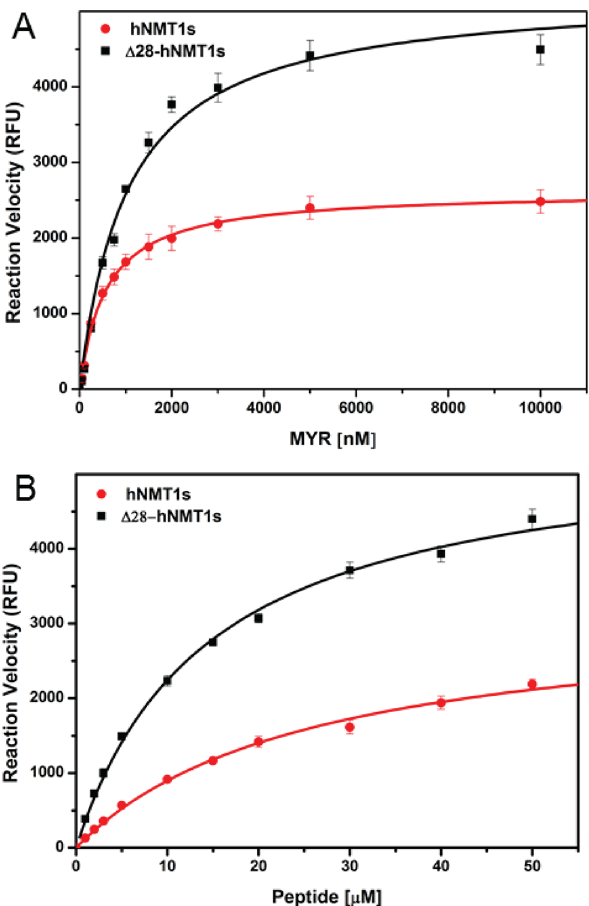
Fig 6. Analyses of catalytic efficiencies of hNMT1s and Δ 28-hNMT1s. Enzymatic activity of 5 nM of hNMT1s and Δ 28-hNMT1s was assayed in 200 μ l of 20 mM sodium phosphate buffer (pH 7.5) with 0.5 mM EDTA, 0.5 mM EGTA, and 0.1% (v/v) Triton X-100 at 25°C using the fluorescence assay as described under “ materials and methods ” . Plots of reaction velocity versus substrate concentration were subjected to Michaelis-Menten analysis as defined by Equation 1 under “ materials and methods ” . A , Michaelis-Menten analysis of MYA as a substrate of NMT catalyzed myristoylation at a peptide substrate concentration of 50 μ M and B , Michaelis-Menten analysis of peptide substrate by NMT catalyzed myristoylation at a MYA substrate concentration of 30 μ M. Errors bars represent the standard deviation and are from triplicate measurements. The Michaelis constant ( K m ) and its standard deviation provided under Table 3 are from the results of the curve fitting by nonlinear regression analysis to the data points.